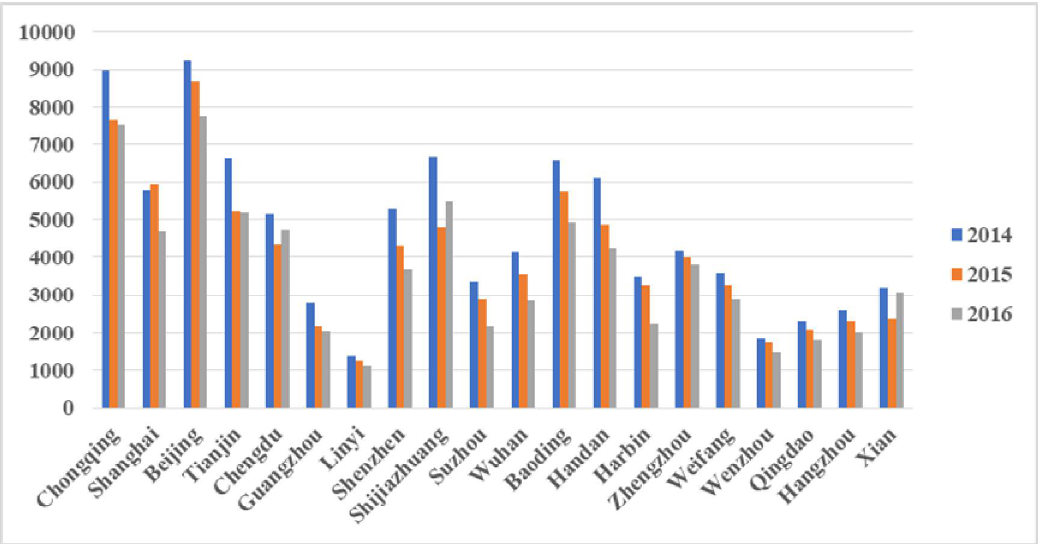
Figure 2. PM 2.5 -related health impacts (all-cause mortality) in 20 major cities in China during the period 2014–2016.